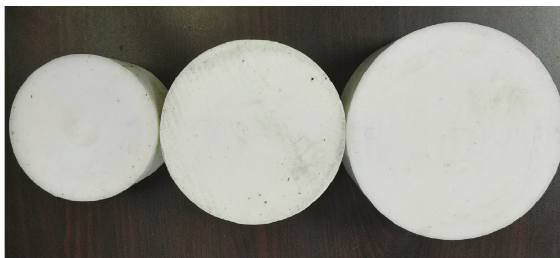
Figure 9: Teflon samples with different diameters.